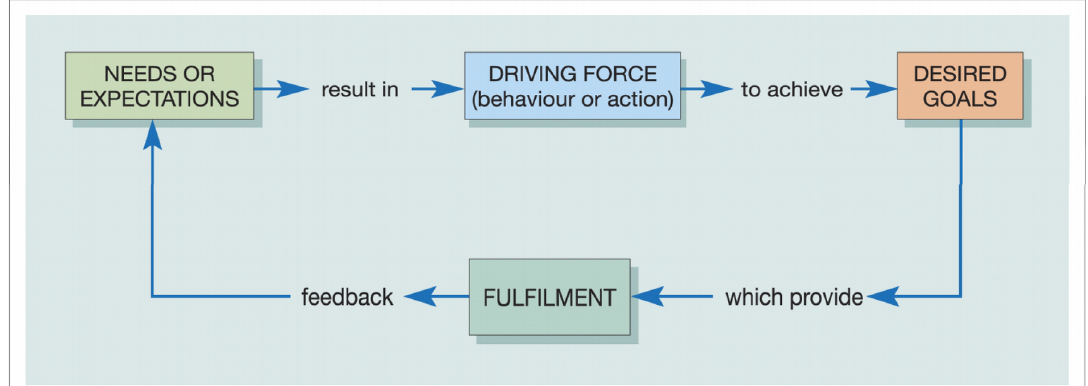
Figure 1. Conceptual Framework (Mullins,